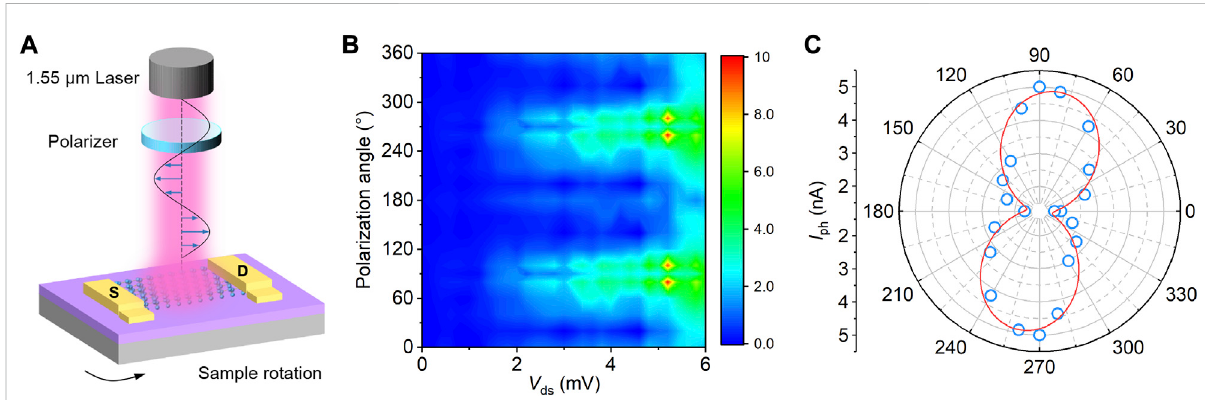
FIGURE 6 Polarized infrared photoresponse of the Te transistor under the incident wavelength of 1.55 μ m. (A) Schematic experimental setup for measuring the polarization-resolved photoresponse. (B) Contour plot of polarized photoresponse characteristics of the Te phototransistor under constant 340 mW 1,550 nm illumination. (C) Polar plot of the I ph as a function of the sample rotation angle, the V ds is 6